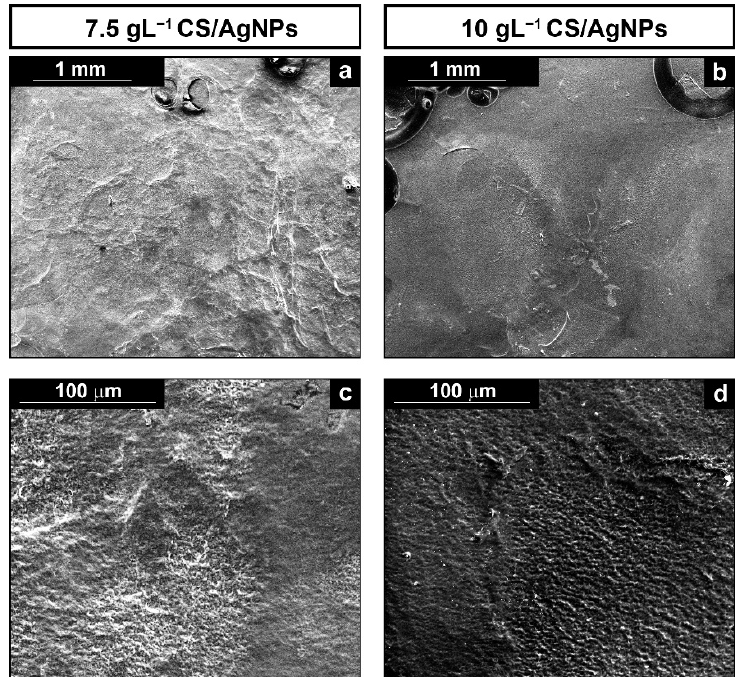
Figure 2. SEM images of deposits obtained using different CS concentrations: ( a , c ) low and high SEM magnification of the composite coating obtained using 7.5 gL − 1 of CS solution; and ( b , d ) low and high SEM magnification of the composite coating obtained using 10 gL − 1 of CS solution.